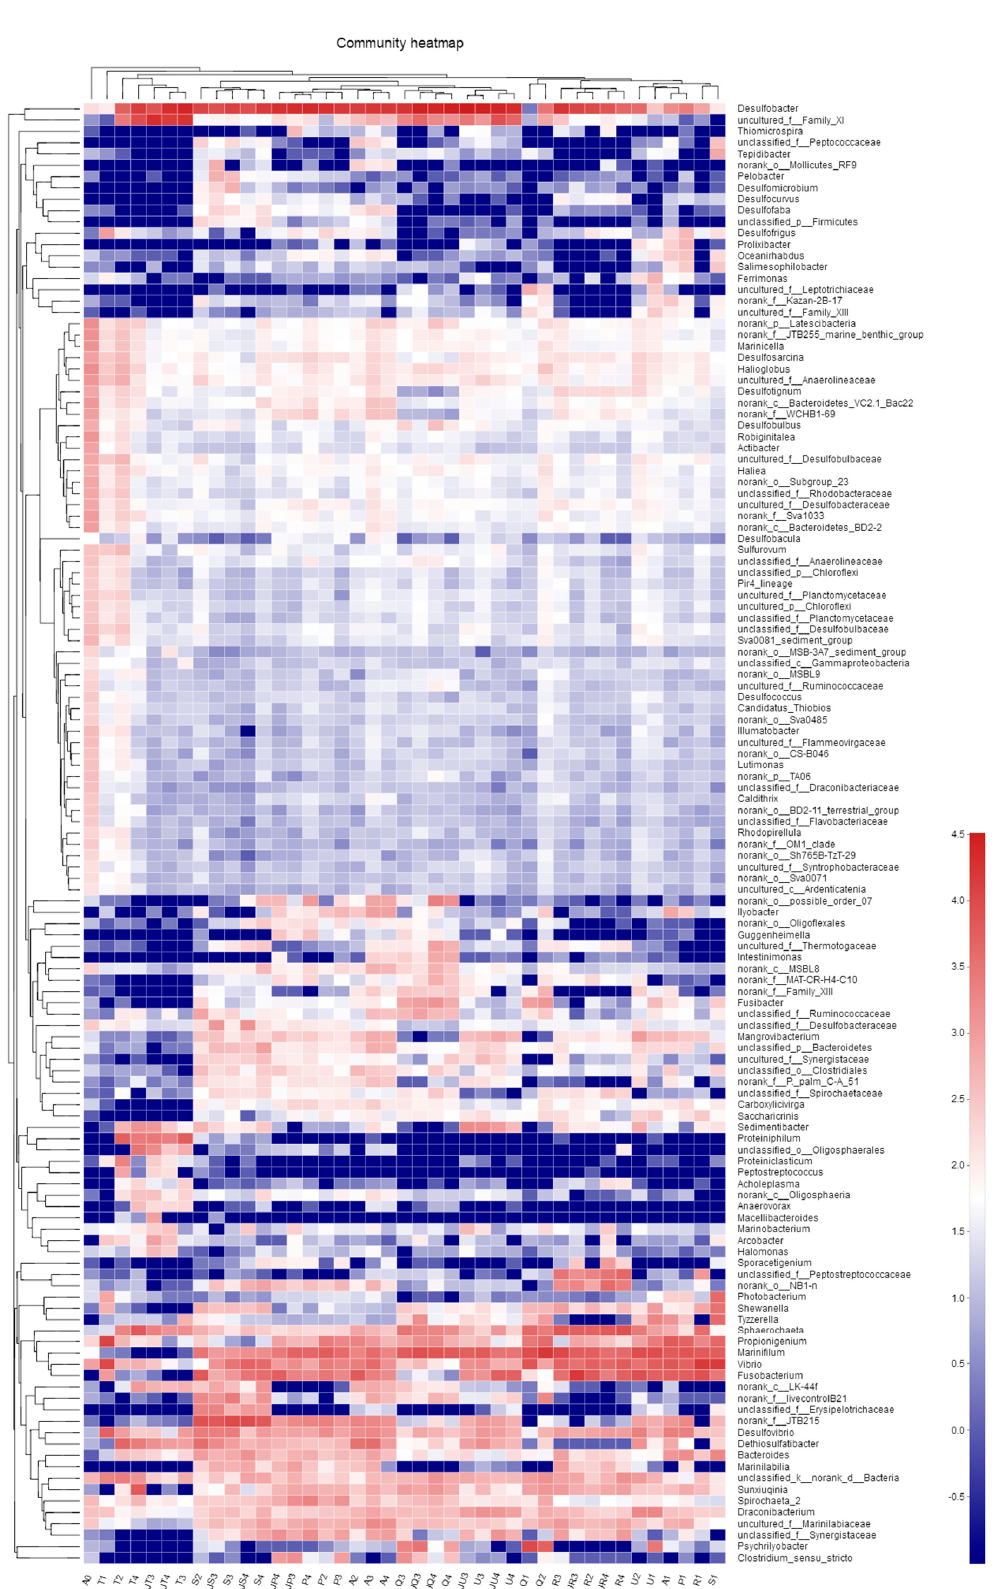
5 Figure 8. Abundant genera (abundance > 0.5%) for each sample (a total of 129 genera for all samples). Both genus and the samples were ordered by the attribution order of cluster